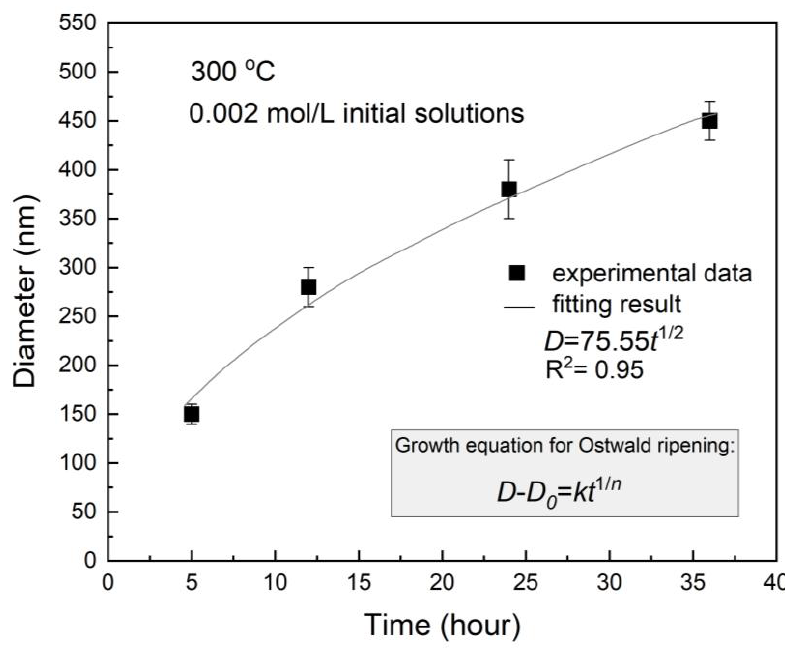
Figure 8. Experimental data and fitting results showing maximum diameter sizes of OsO 2 crystals vs. time at 300 °C and 100 MPa in 0.002 mol/L initial solutions.